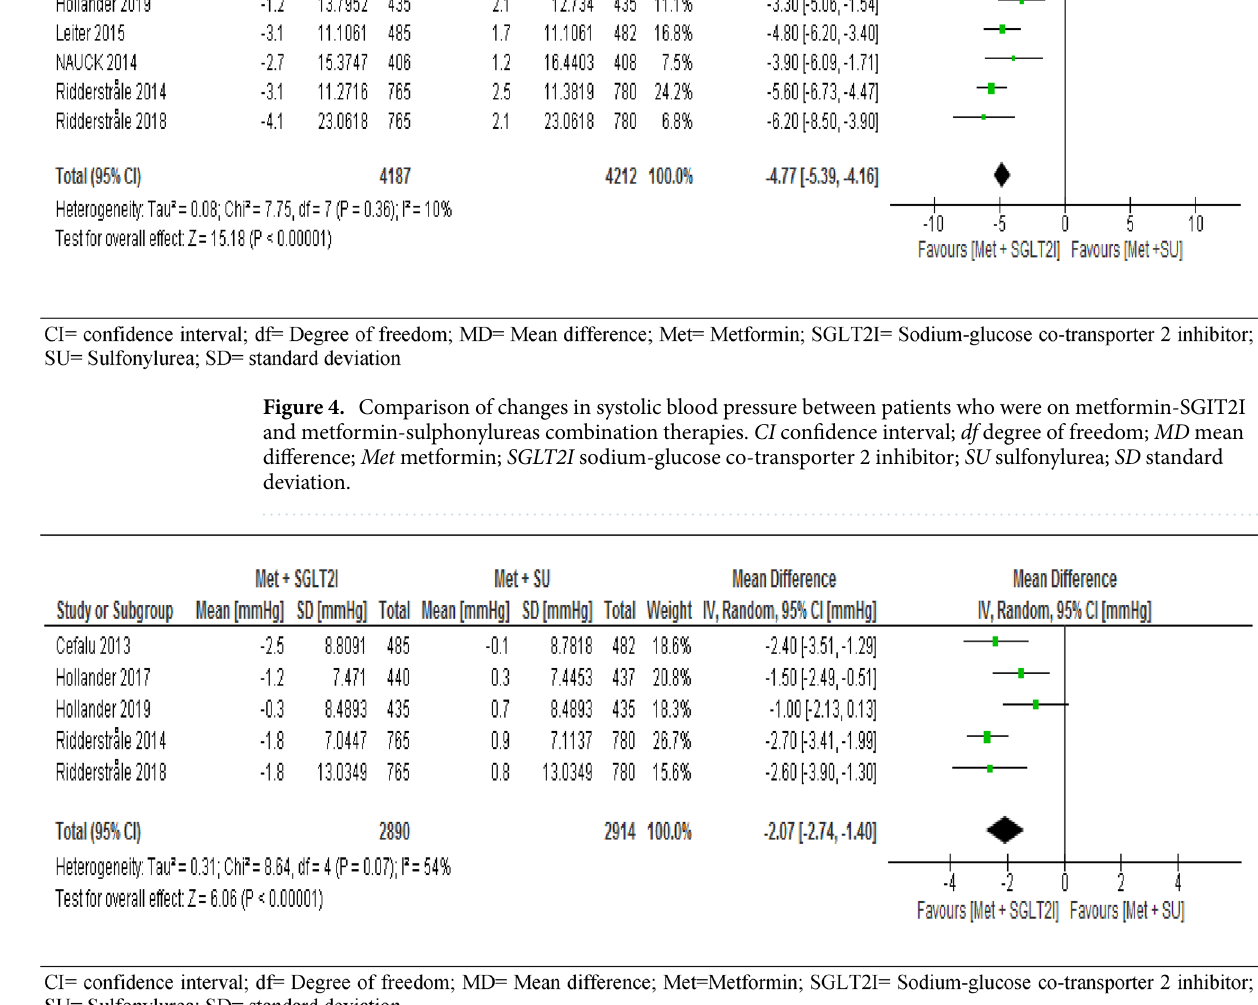
Figure 5. Comparison of changes in diastolic blood pressure between patients who were on metformin-SGIT2I and metformin-sulphonylureas combination therapies. CI confidence interval; df degree of freedom; MD mean difference; Met metformin; SGLT2I sodium-glucose co-transporter 2 inhibitor; SU sulfonylurea; SD standard